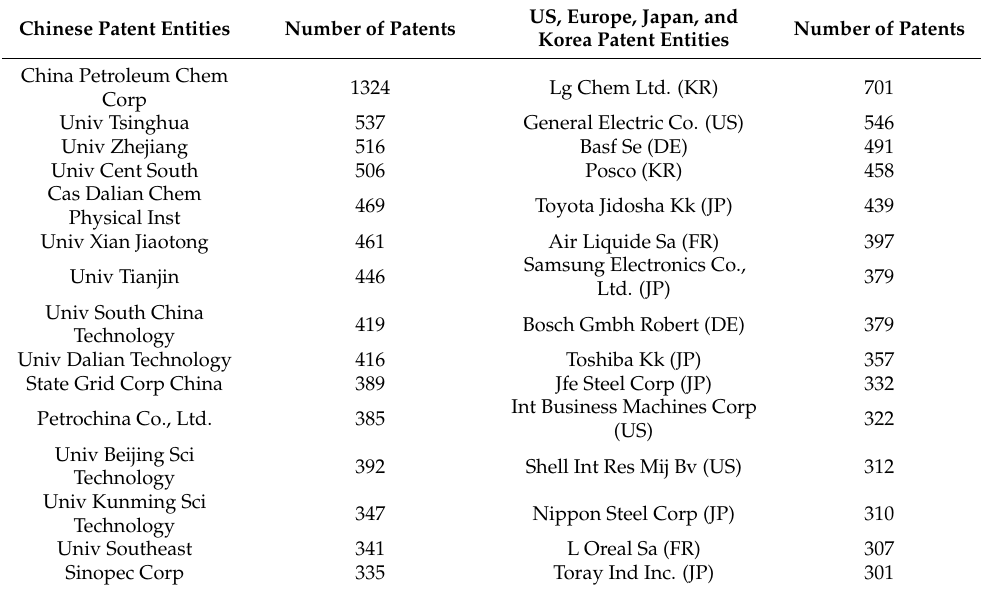
Table 4. Top 15 patent entities and their patent numbers in CCUS patent applications in China and in US, Europe, Japan, and